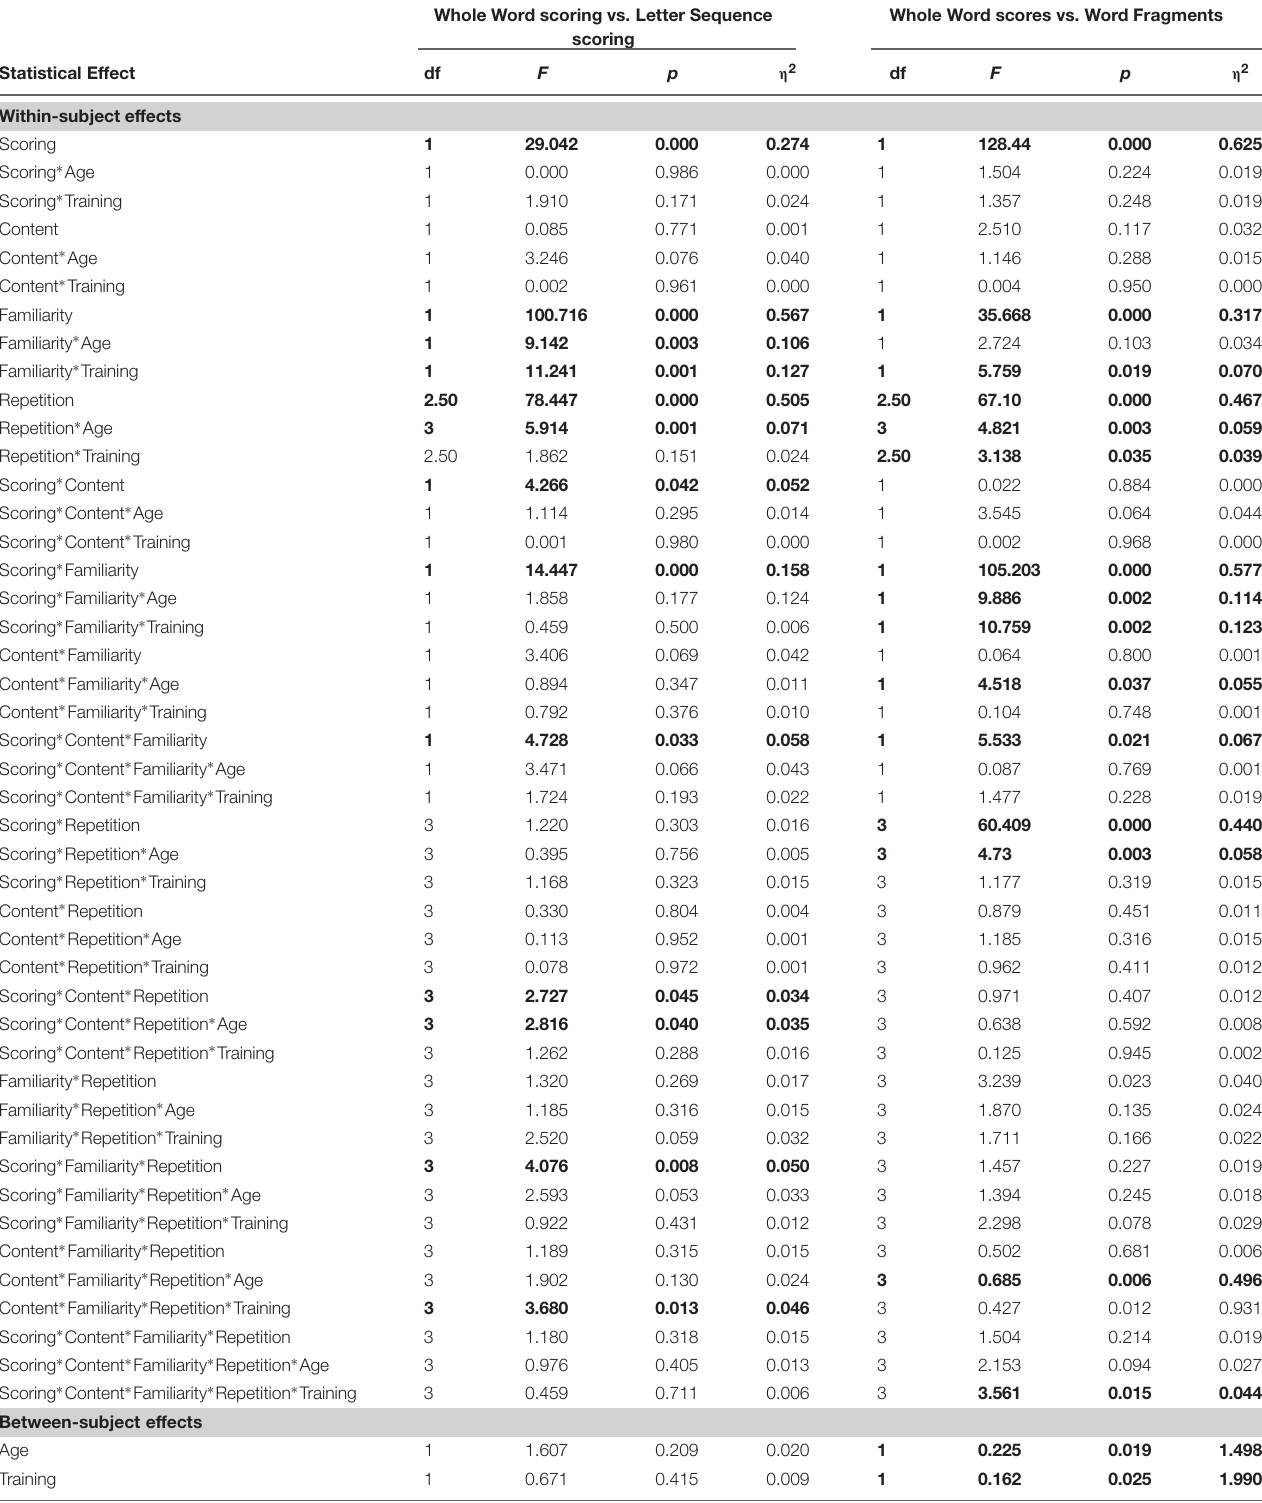
TABLE 3 | MANOVA Table of Statistical Effects, n = 80, for Scoring Method (left) and Composite Scores (right) Analyses of variance with repeated measures for Repetition (four times), Familiarity (low/high) and Content (words vs. geographical places). Whole Word scoring vs. Letter Sequence Whole Word scores vs. Word scoring